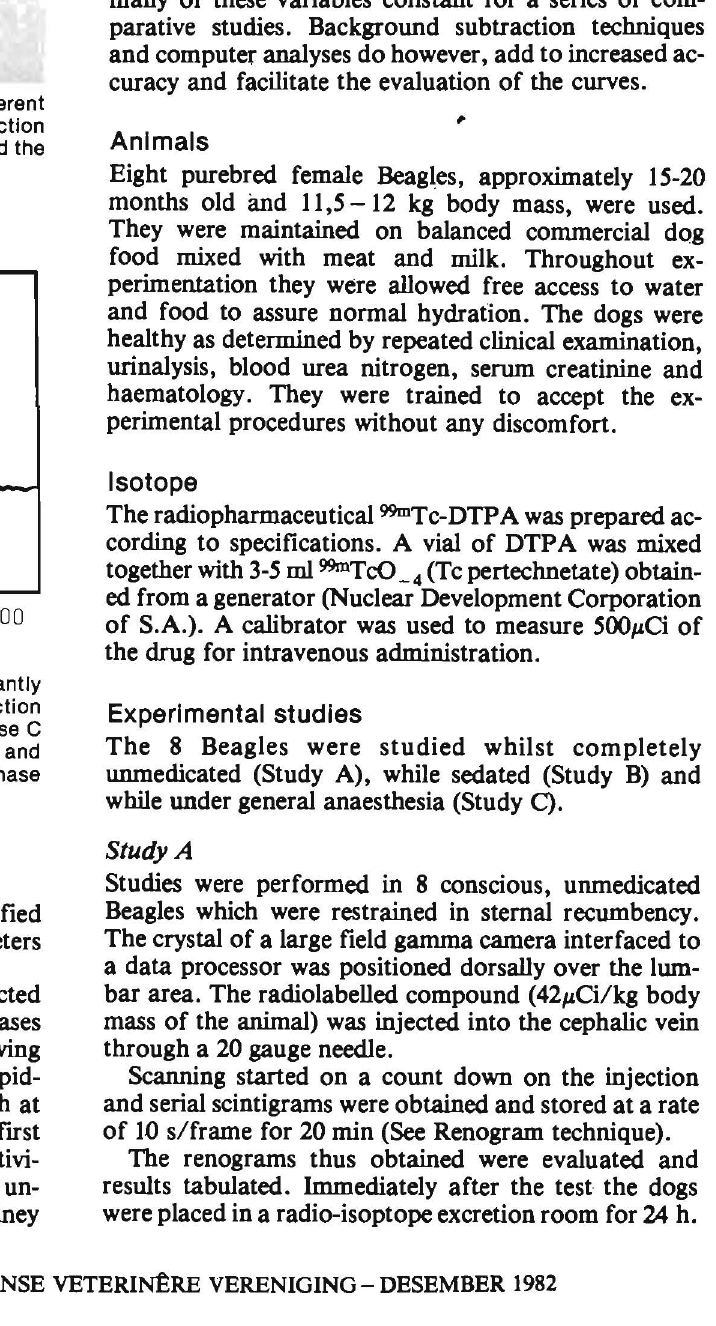
Fig. 1: Scintigram illustrating 4 frames (A to 0) at different times of the renogram. Note the progressive reduction In cardiac activity (1) the prominent kidneys (2) and the filling of the bladder (3).